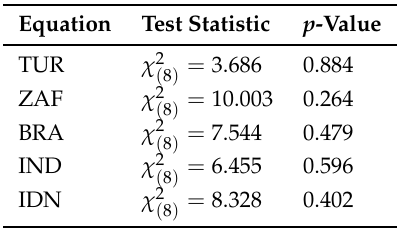
Table 4. Breusch–Pagan test.